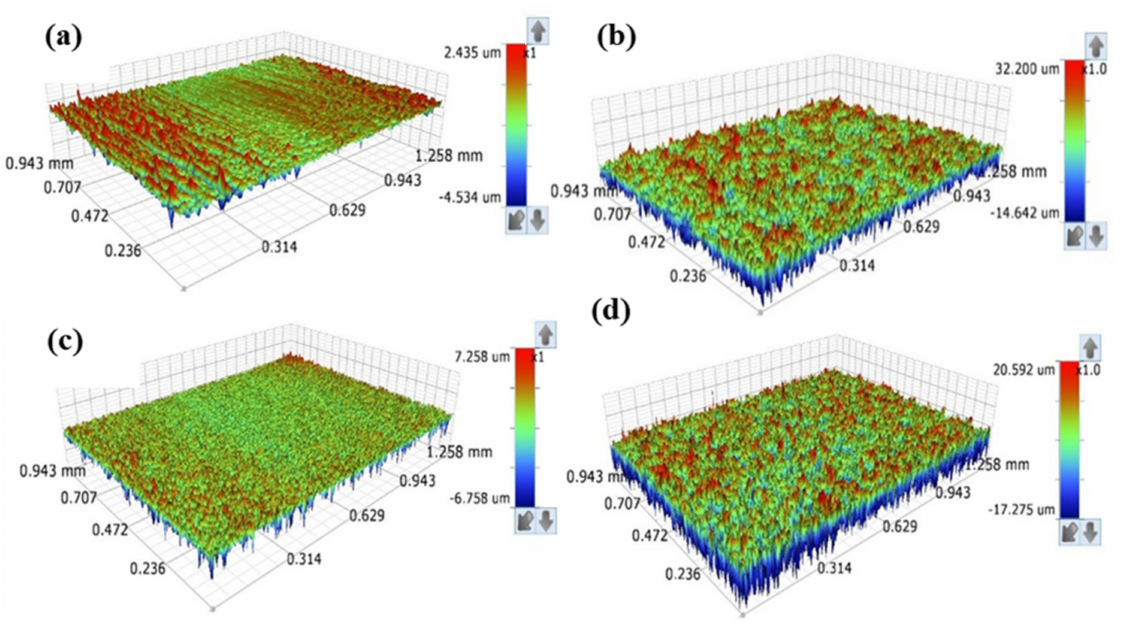
Figure 5. 3D surface topography for pretreated and treated Ti64 alloy: ( a ) M, ( b ) SB, ( c ) MT, ( d ) SBT.